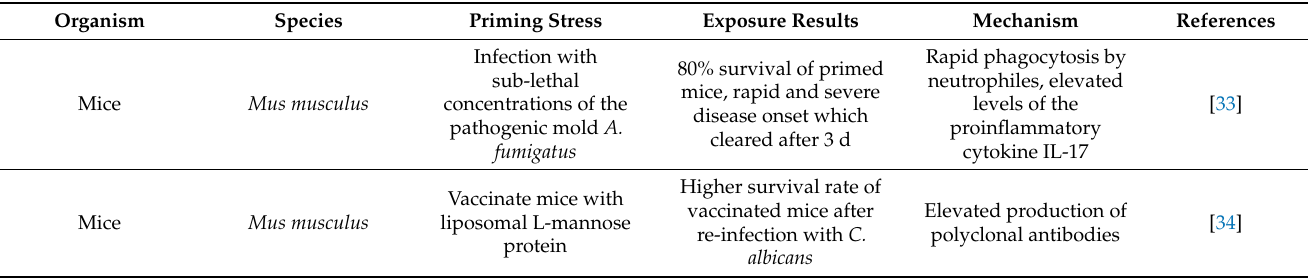
Table 1. Animal, plant, and bacterial